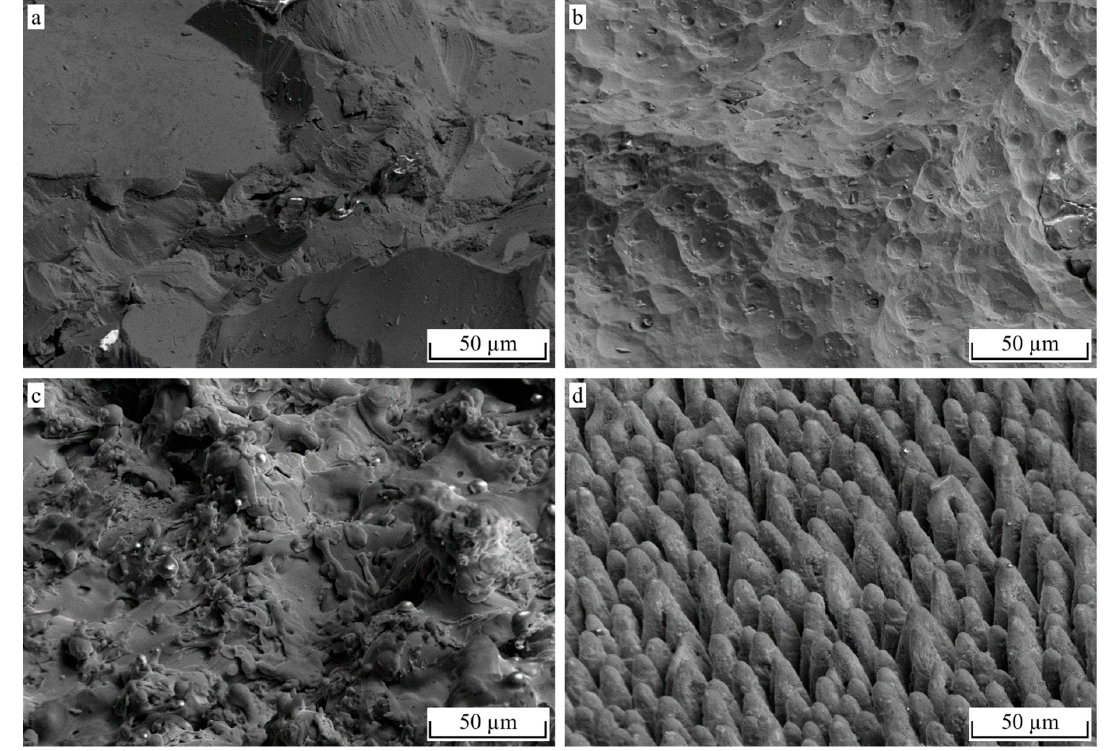
Figure 14. SEM images of hollow cylinder specimens, 60° tilt, 25 kV ( a ) F16, 2 bar ( b ) F16, 3 bar + 5 min NaOH ( c ) NiAl5 coating and ( d ) pin structure.